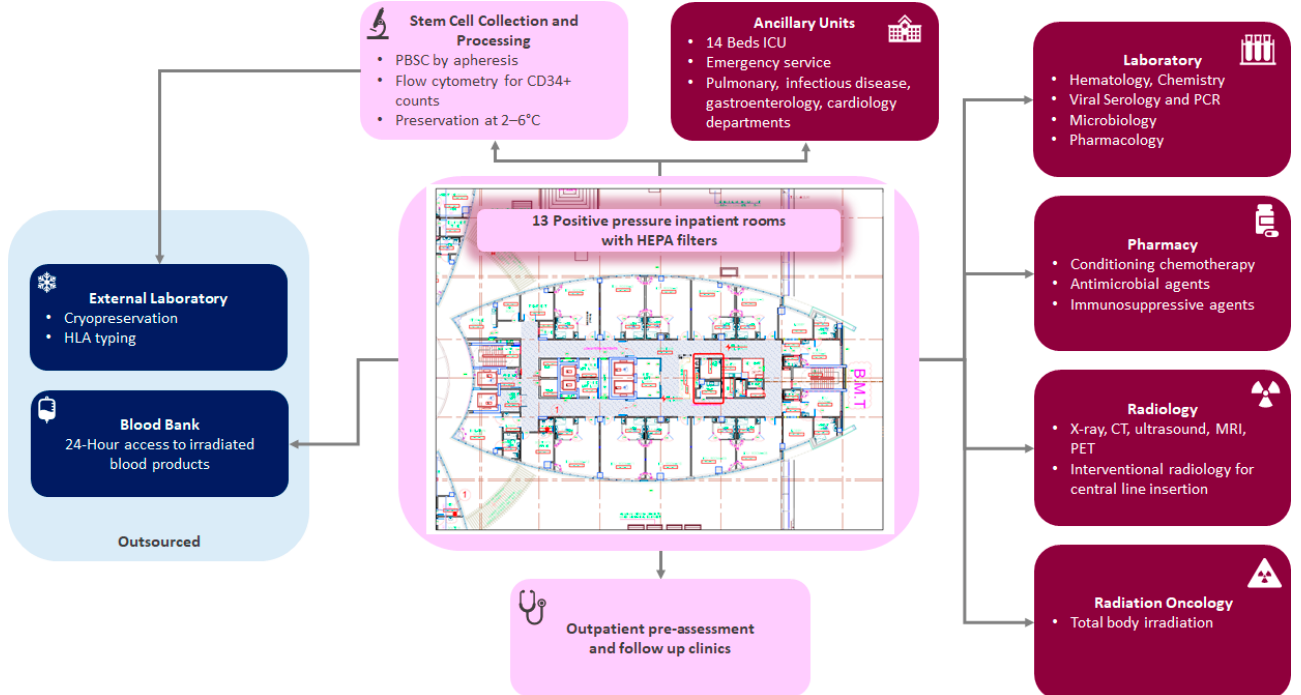
Figure 1. Hematopoietic stem cell transplant unit current set up. HLA, human leukocyte antigen; PCR, polymerase chain reaction; HEPA, high-efficiency particulate absorbing; PBSC, peripheral blood stem cells; ICU, intensive care unit; CT, computed tomography; MRI, magnetic resonance imaging; PET, positron emission tomography.